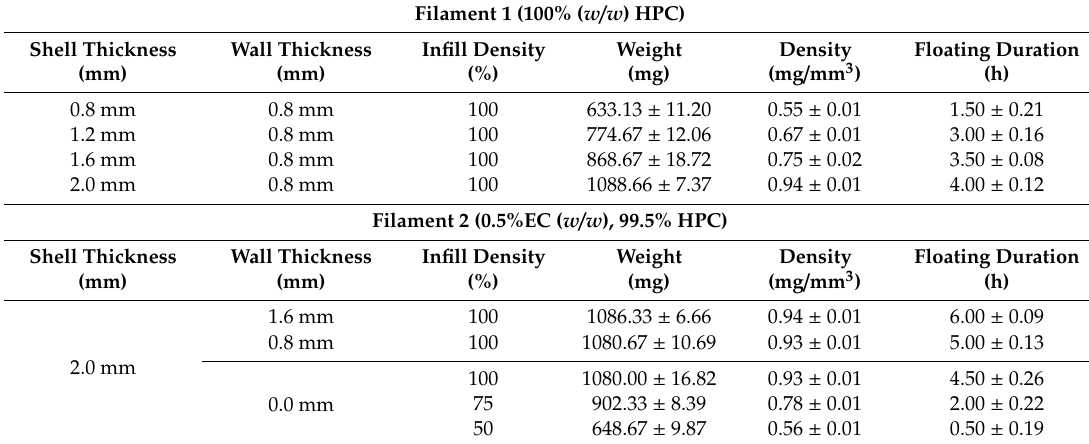
Table 1. Physical properties of the 3D printed floating